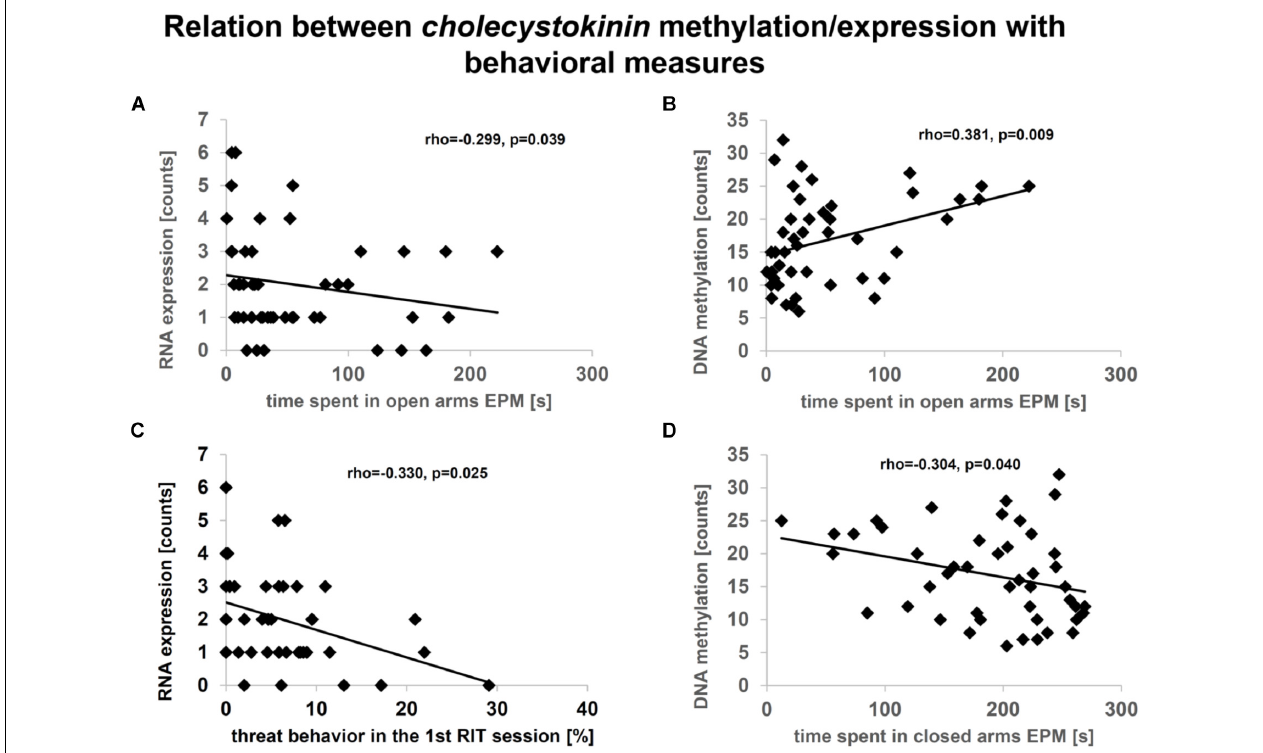
FIGURE 6 | Relationship between cholecystokinin (Cck) expression (A, C) or methylation (B, D) in amygdala and behavior. Data based on sequencing counts of total RNA and methyl-CpG-binding domain (MBD) capture-based, enriched loci ( n /group = 6–8). Analysis was performed using the non-parametrical Spearman correlation. Spearman correlation coefficient rho and p -value are reported. Correlation analysis was performed over all